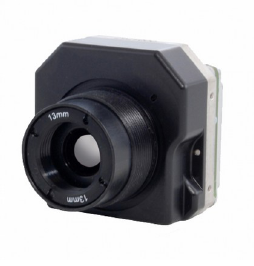
Figure 9. Flir Tau 2 camera with different lens